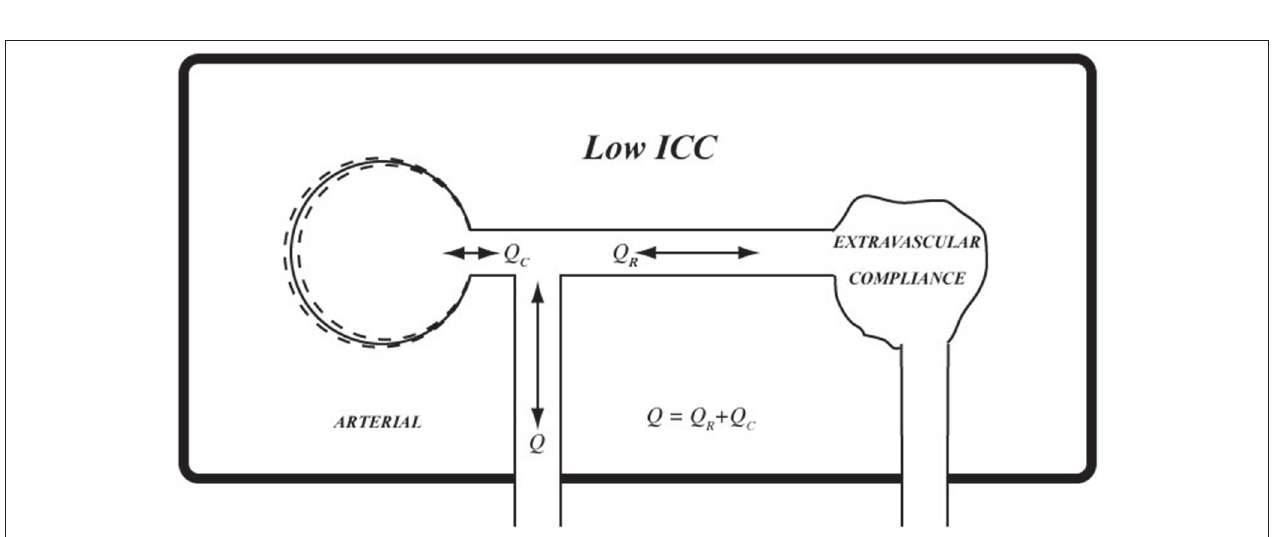
FIGURE 9 | Using the same analogy as in Figure 8 , at low ICC extravascular compliance may be likened to a deflated balloon which provides very little or no extravascular compliance.